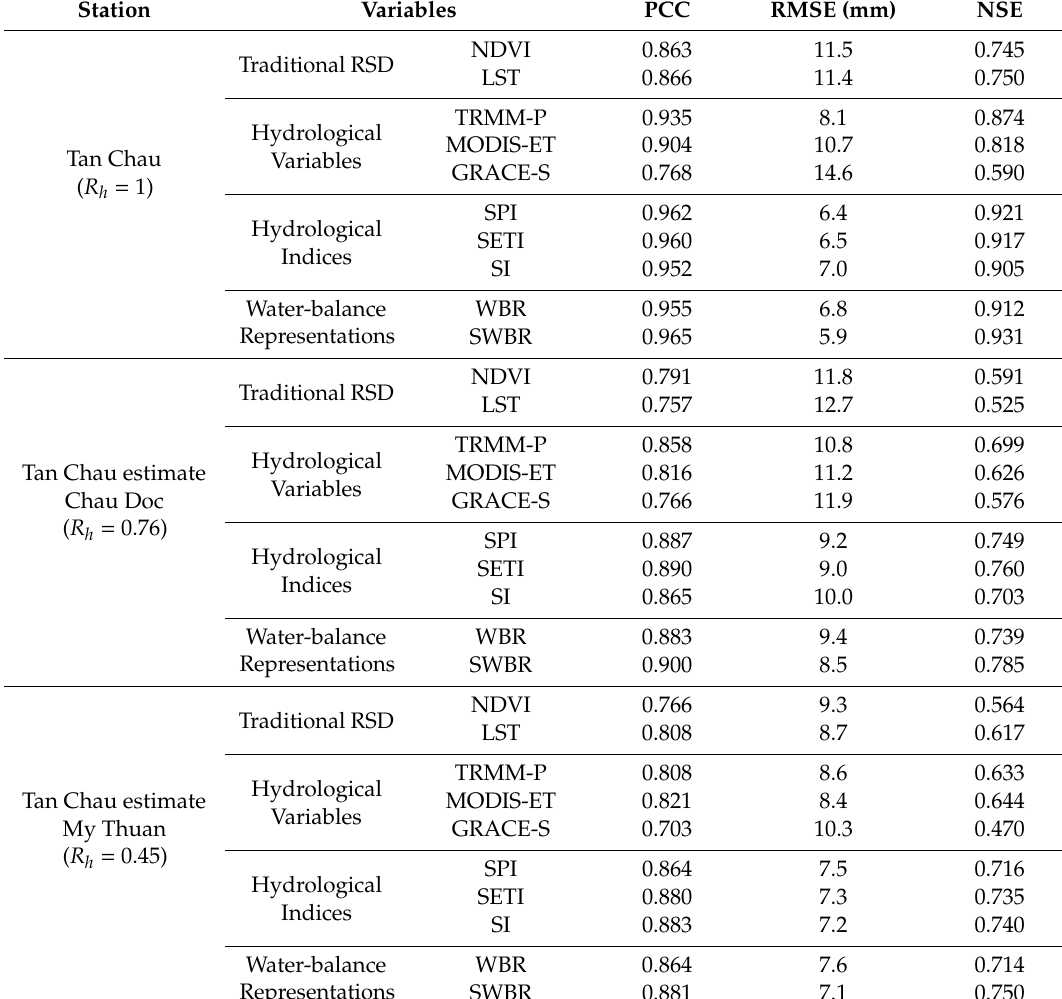
Table 3. Internal assessment of R , reconstructed using data from Tan Chau station, and external assessment of the R , estimated for Chau Doc and My Thuan stations. The legend ‘Tan Chau estimate Chau Doc’ (or ‘My Thuan’) means that the R for Chau Doc (or My Thuan) was estimated based on the reconstructed relationships between the R from Tan Chau station and the abovementioned